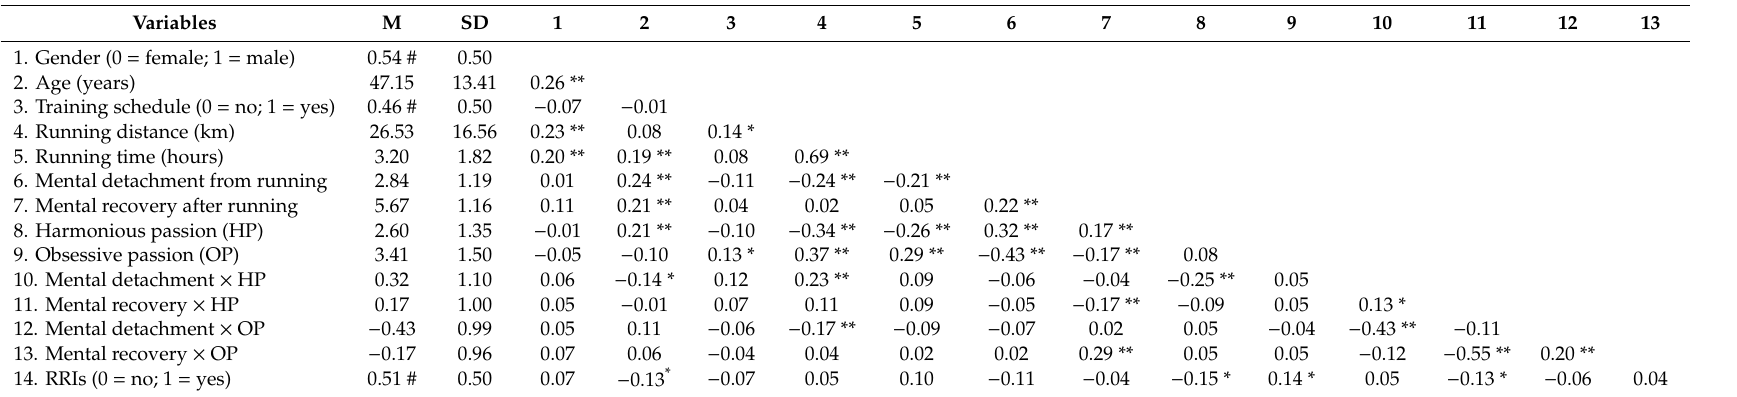
Table 1. Descriptive statistics and Pearson zero-order correlations among study variables ( n =